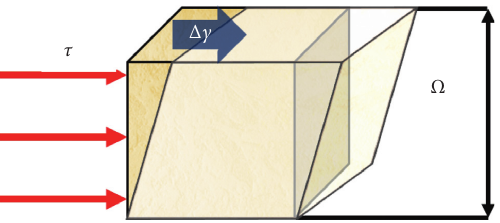
Figure 7: Principle of work done by the internal force of